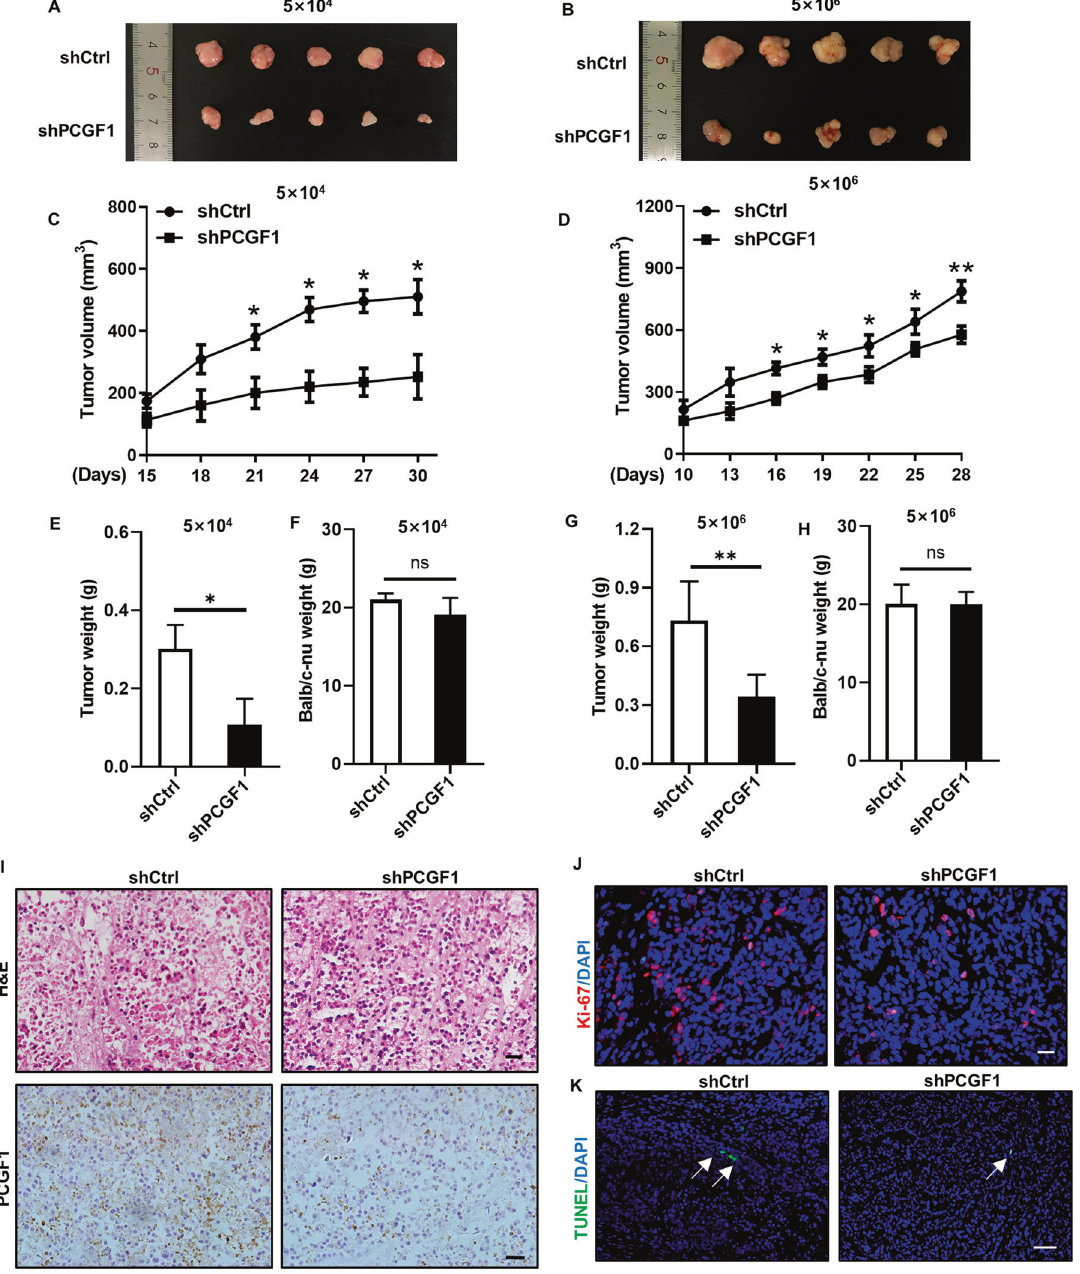
Fig. 6 PCGF1 knockdown inhibits tumour growth in vivo. A , B Tumour size in nude mice after control and shPCGF1 HCT116 CRC cell injection on the day of harvest. C , D Tumour volume was measured every 3 days. Comparisons were performed for the shPCGF1 group versus the control group. E – H The histogram shows the average tumour weight and mouse weight of the two groups. n = 5 per group; error bars represent the SEM; **P < 0.01, *P < 0.05 versus control; one-way ANOVA and t -test. I Tumour sections were subjected to H&E staining and IHC using antibodies against PCGF1. H&E staining and IHC, scale bar, 20 µm. J , K Immuno fl uorescence staining of Ki-67 (red) and TUNEL (green) was performed to evaluate the proliferation of tumour cells. DAPI was used to stain the nuclei (blue). Ki-67 staining, scale bar, 20 µm; TUNEL staining, scale bar, 50